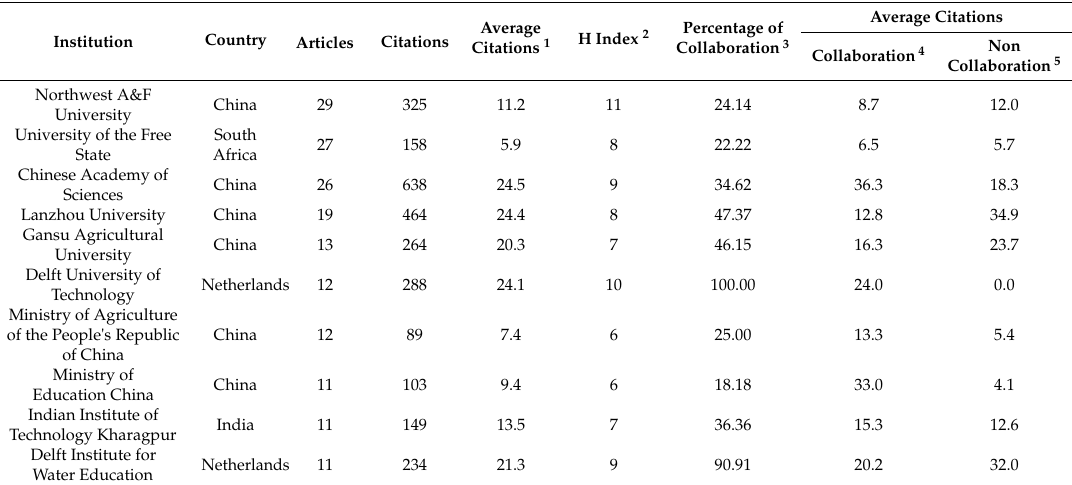
Table 6. Main characteristics of the most active institutions in RWHI